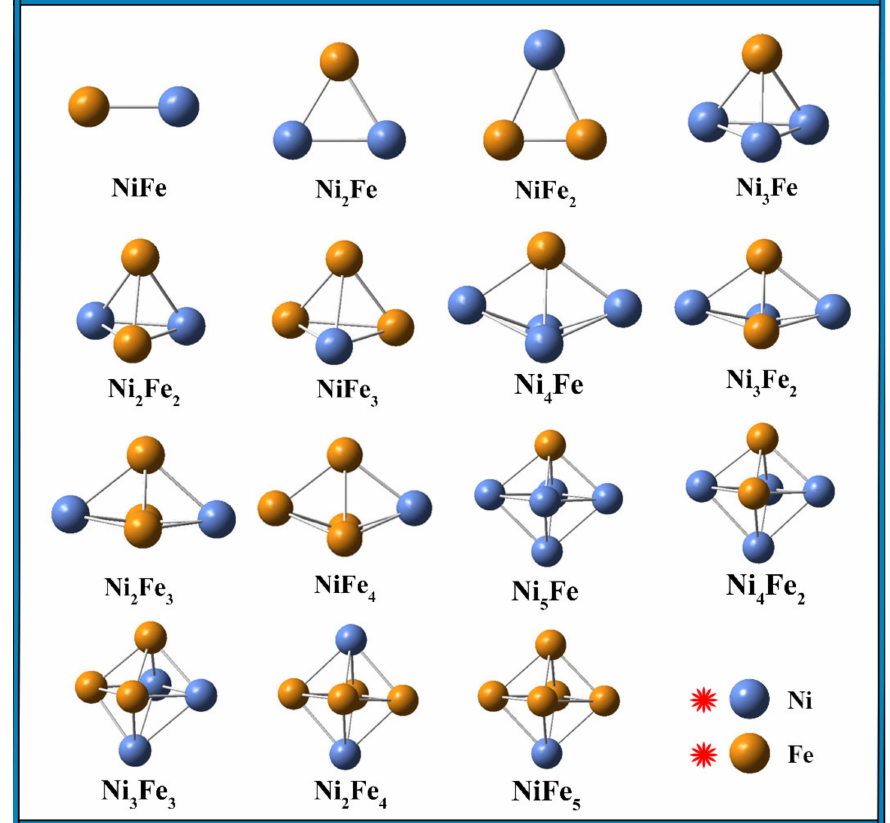
Figure 1. Optimized structures of the Ni a Fe b (2 ≤ a + b ≤ 6) clusters at the B3LYP / LANL2DZ